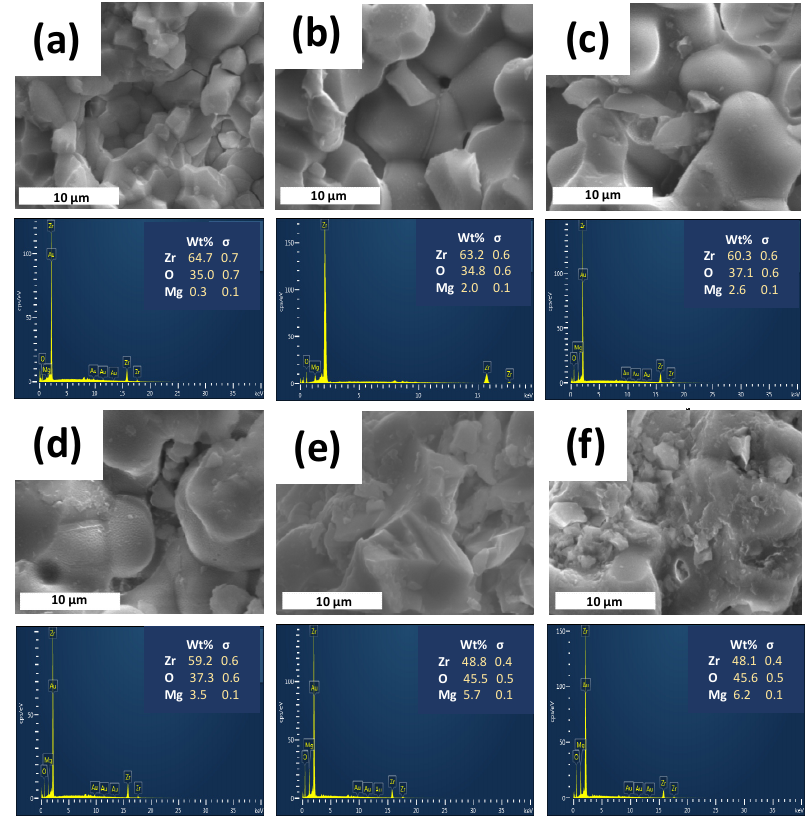
Figure 4. SEM images ( up ) and the corresponding EDS spectra ( down ) of ( a ) x = 0.05, ( b ) x = 0.1, ( c ) x = 0.15, ( d ) x = 0.2, ( e ) x = 0.25 and ( f ) x = 0.3 compositions belonging to the Zr 1 − x Mg x O 2 system, after immersion in Xerostom ® saliva substitute gel.